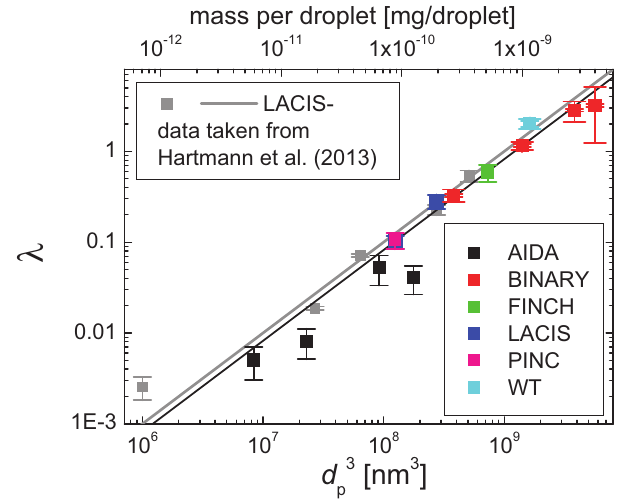
Figure 9. Average number of INM per particle or droplet as a func- tion of the third power of particle diameter or mass per droplet, respectively, for data sets that showed a clear plateau with f ∗ Grey symbols represent data published in Hartmann et al. (2013). The grey line is the corresponding fit function derived in Hartmann et al. (2013), which also describes the data collected in the present study well. The black line represents a fit obtained for this study (for details see